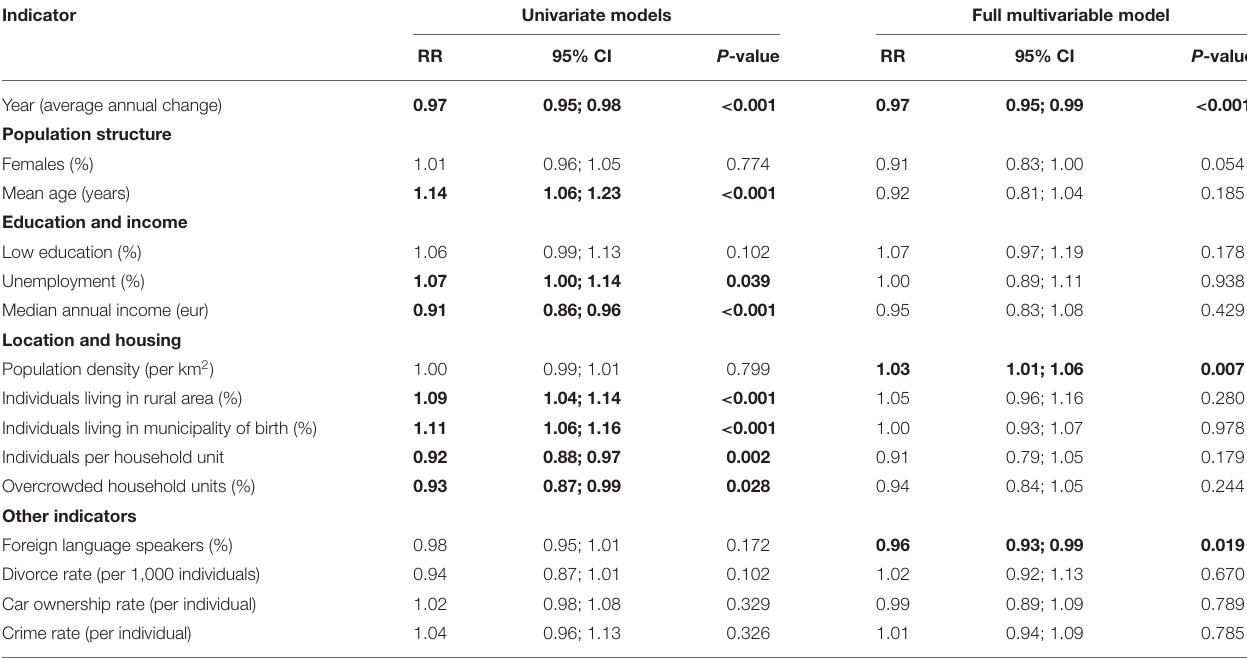
TABLE 2 | Sociodemographic indicators of child and adolescent mortality.